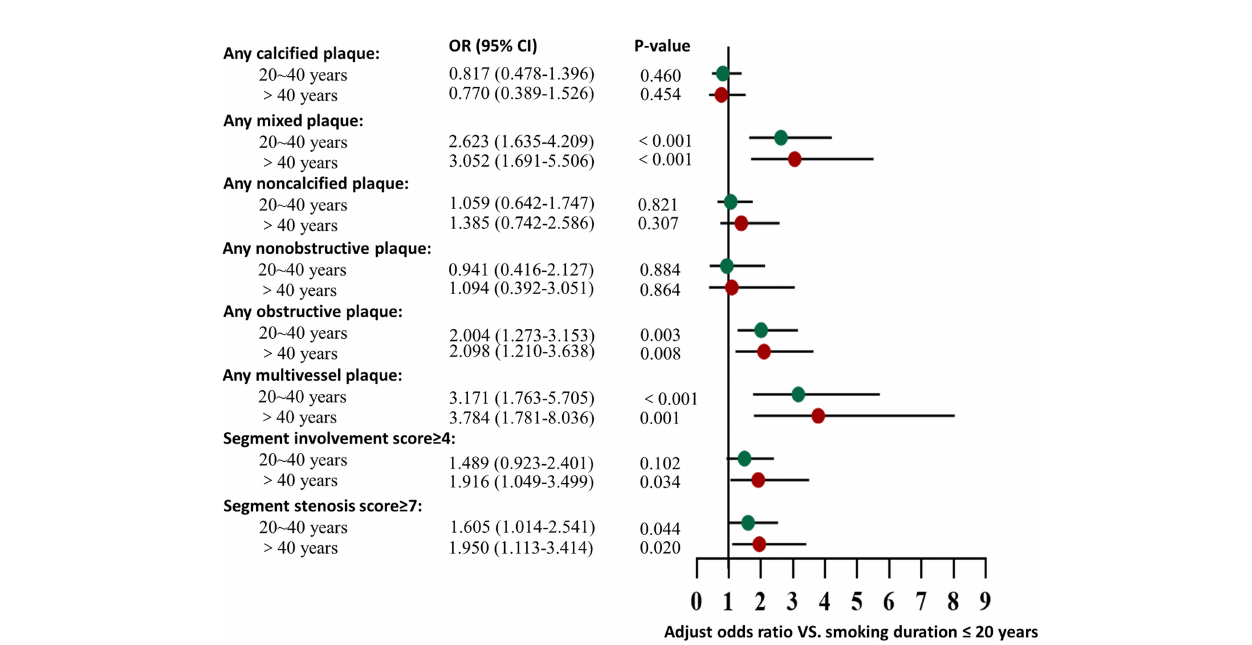
FIGURE 5 | Association of smoking duration with CCTA measures. Adjusted odds ratio of all types of plaque, severity, and extent by comparison to DM patients with a smoking history ≤ 20 years, among DM patients with a smoking history of 20~40 years and > 40 years. The multivariate regression analysis was adjusted for age, sex, BMI, duration of DM, hypertension, dyslipidemia, total cholesterol, high-density lipoprotein cholesterol and low-density lipoprotein